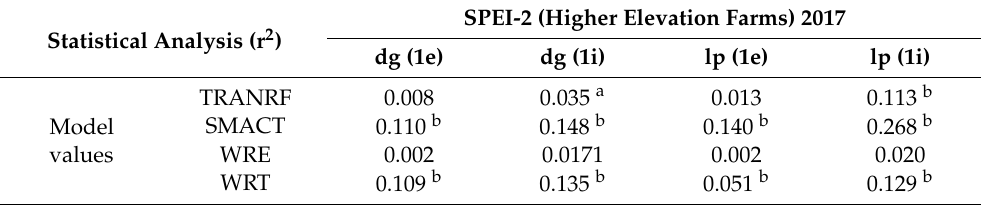
Table 5. Statistical analysis of drought index SPEI-2 at Farms1e and 1i and the LINGRA-N model results of yield (TRANRF, SMACT, WRE, WRT) for year 2017—shown are values of r 2 . Statistical Analysis (r 2 )